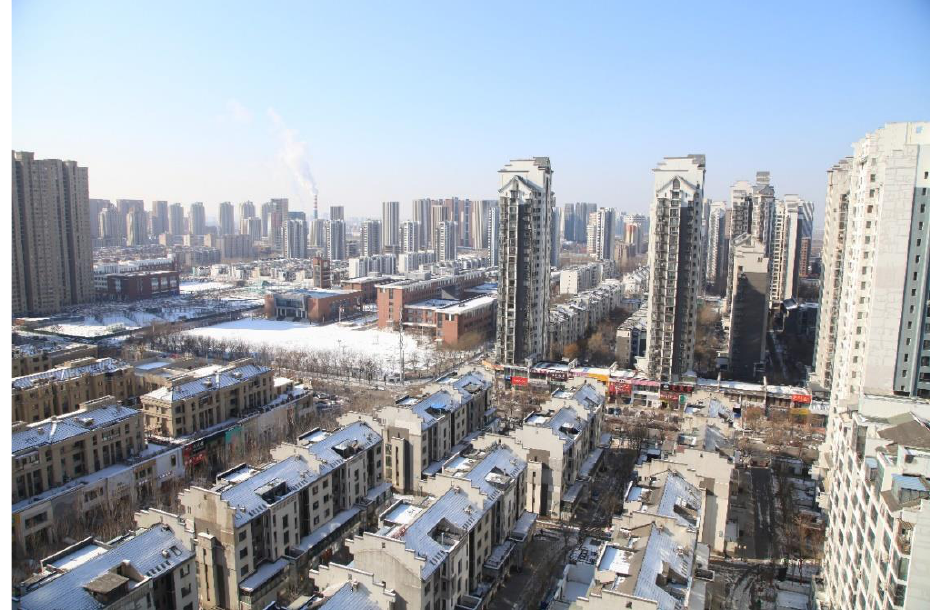
Figure 4. Local three-dimensional urban form in sample area A. Prepared by the authors.